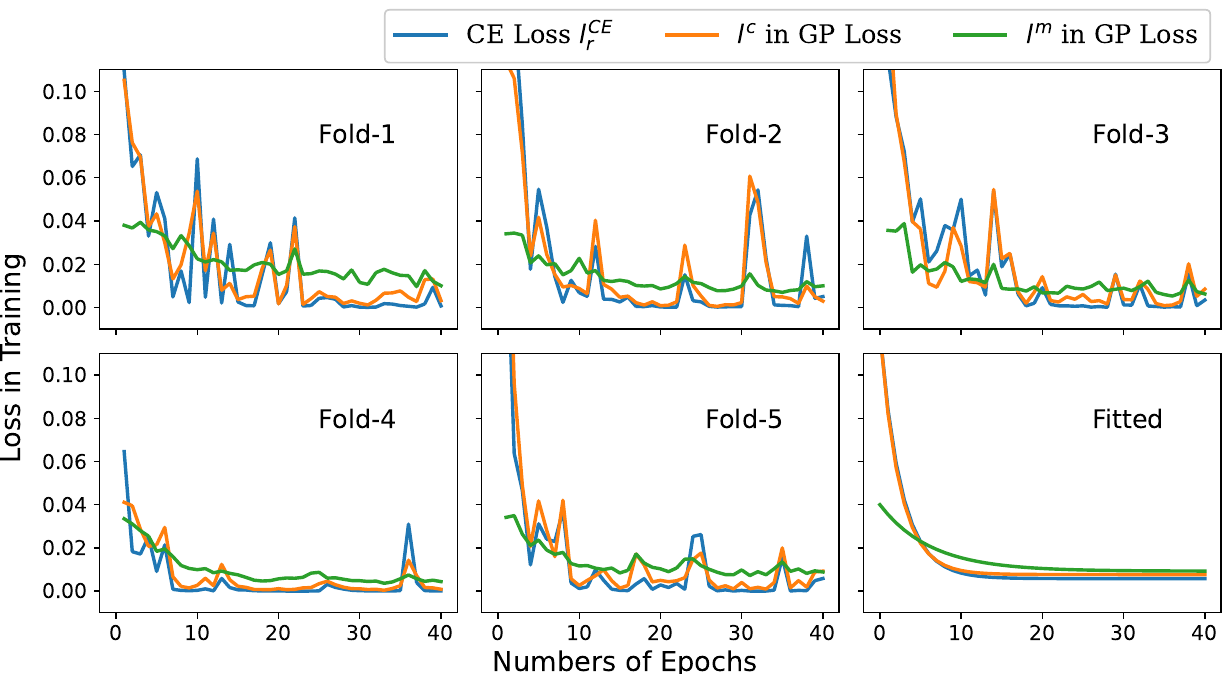
Figure 4. Training losses in the GPGDA algorithm versus Epochs with SynDataI . Average data from five folds could be fitted with a one-phase exponential decay equation ( y = ( y 0 − p ) · e − kx + p , the bottom-right panel, R 2 : 0.68, 0.71, and 0.70 for l CE r , l c , and l m respectively). l CE r and l c followed a similar decay (half-lives: 1.84 and 1.68, respectively, p > 0.05, extra-sum-of squares F-test), while l m followed a more gradual decay (half-life: 4.46, p < 0.001, F-test). The same results were obtained with SynDataN and SynDataM (data not